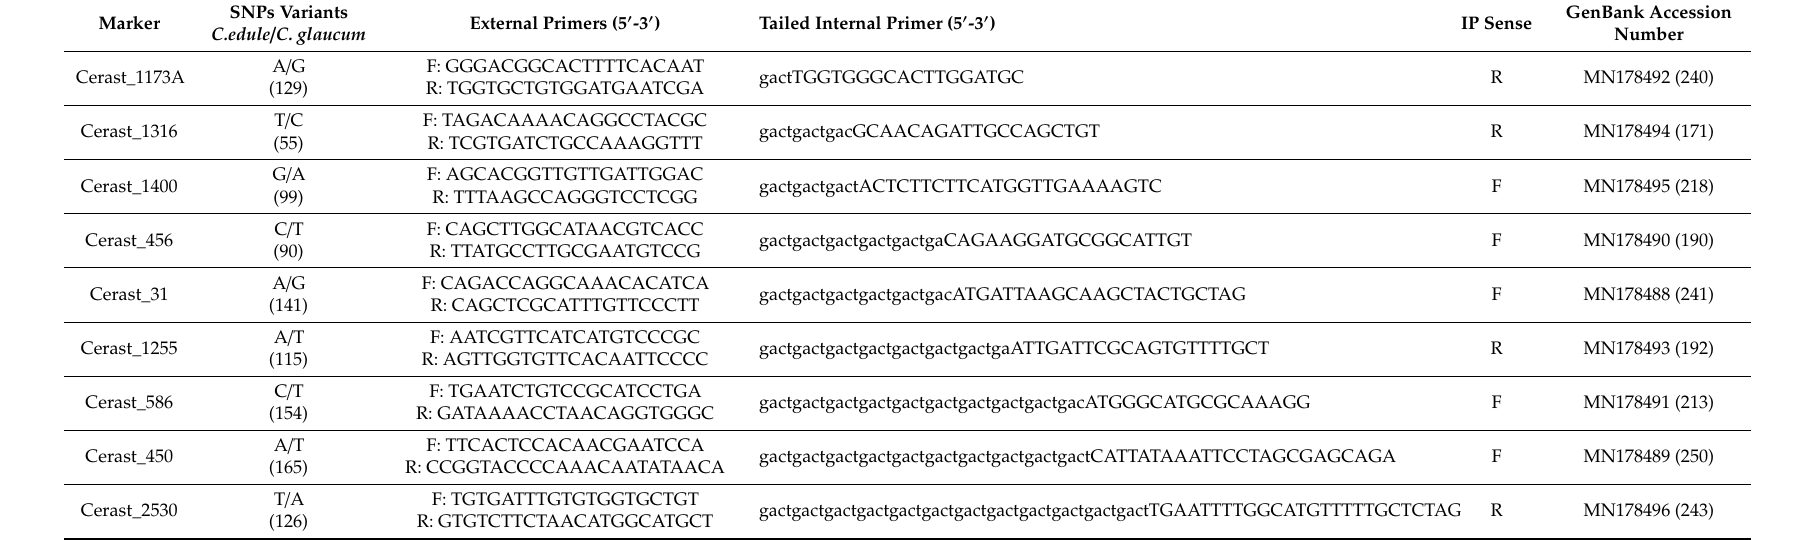
Table 2. External and internal primers (IP) for the two multiplex reactions developed in the present study. Lowercase letters in internal primers indicate the GACT nucleotide tails. Single nucleotide polymorphisms (SNPs) variants (with their position within their submitted GenBank sequence between parentheses), sense of the internal primer (IP sense; F: Forward, R: Reverse) and GenBank accession numbers for the sequences used to design the markers (length in bp of the sequence between parentheses) are